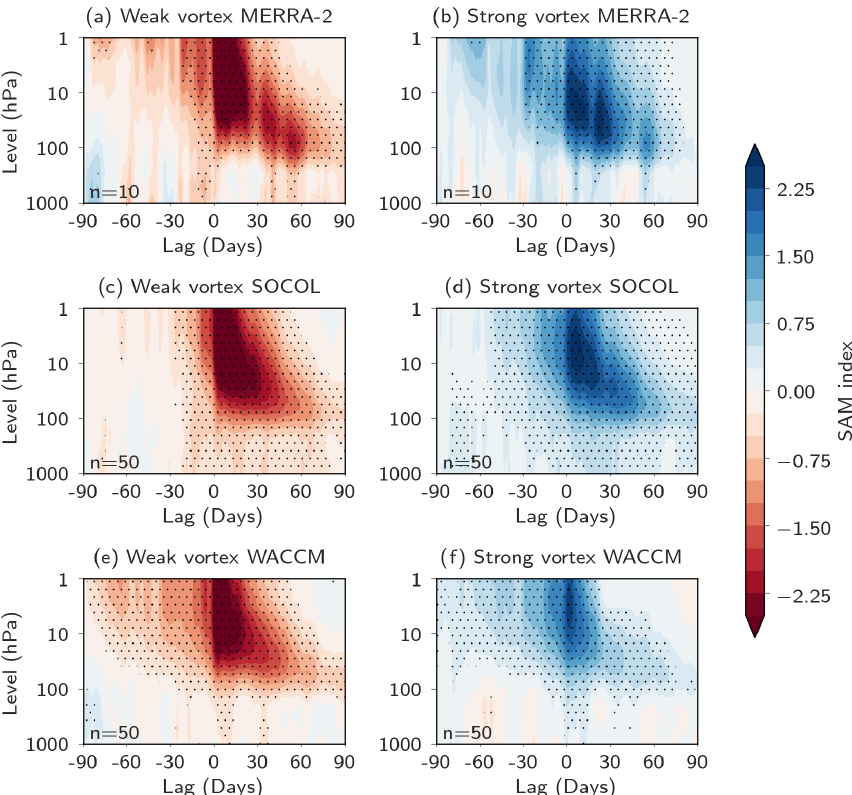
Figure 2. Time–height development of the SAM index following weak and strong polar vortex events for the reanalysis MERRA-2 (a, b) , and the CCMs SOCOL (c, d) and WACCM (e, f) . The central date (lag 0) refers to the first day when the 10hPa SAM values have fallen below − 2 and above + 2, respectively. The indices are nondimensional and stippling refers to significance at the 4.5% level assessed with a bootstrapping